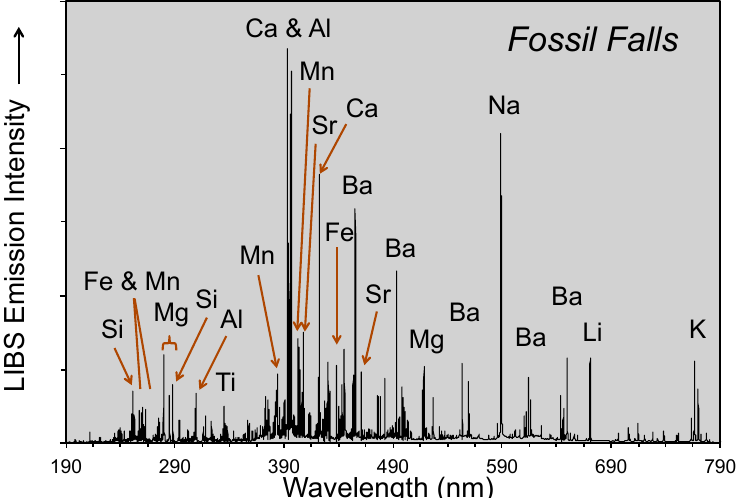
Figure 6. Z-300 LIBS spectra for rock varnish at the Fossil Falls locality on basalt lava at the Fish Springs locality.